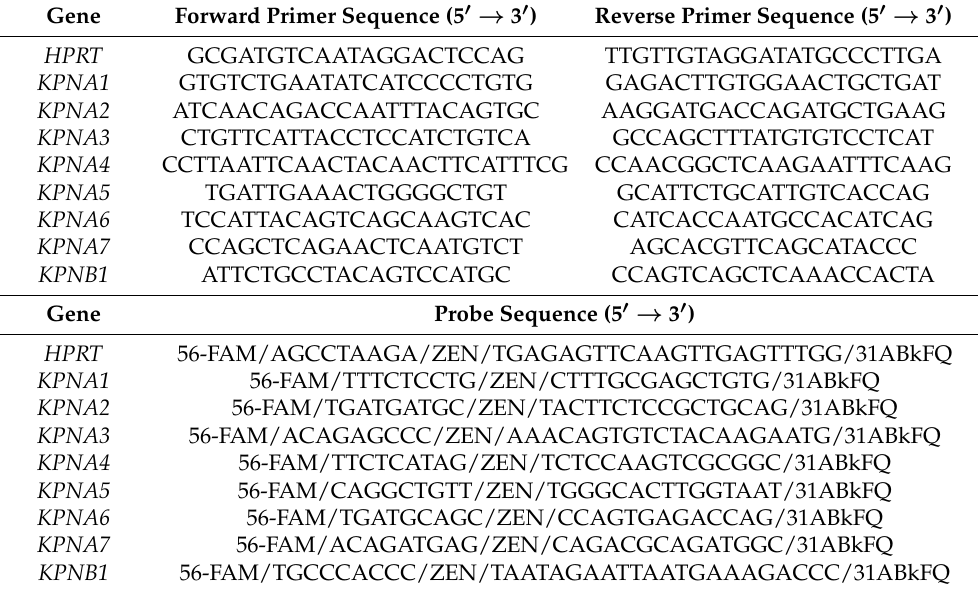
Table 1. PCR primer and probe